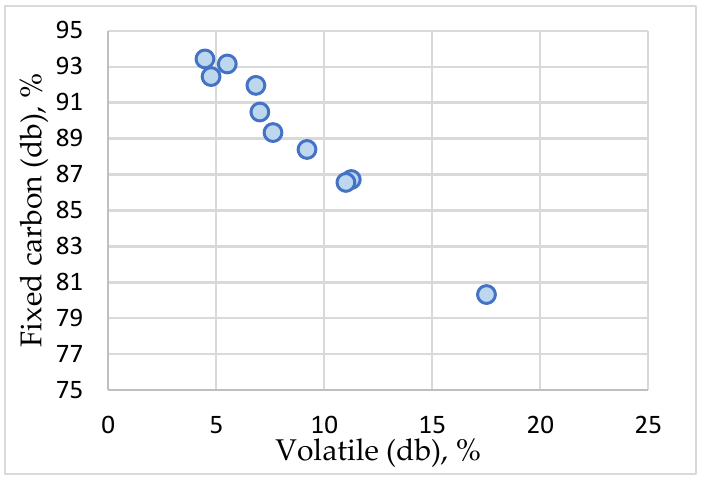
Figure 9. ACMP fixed carbon and volatile matter content.